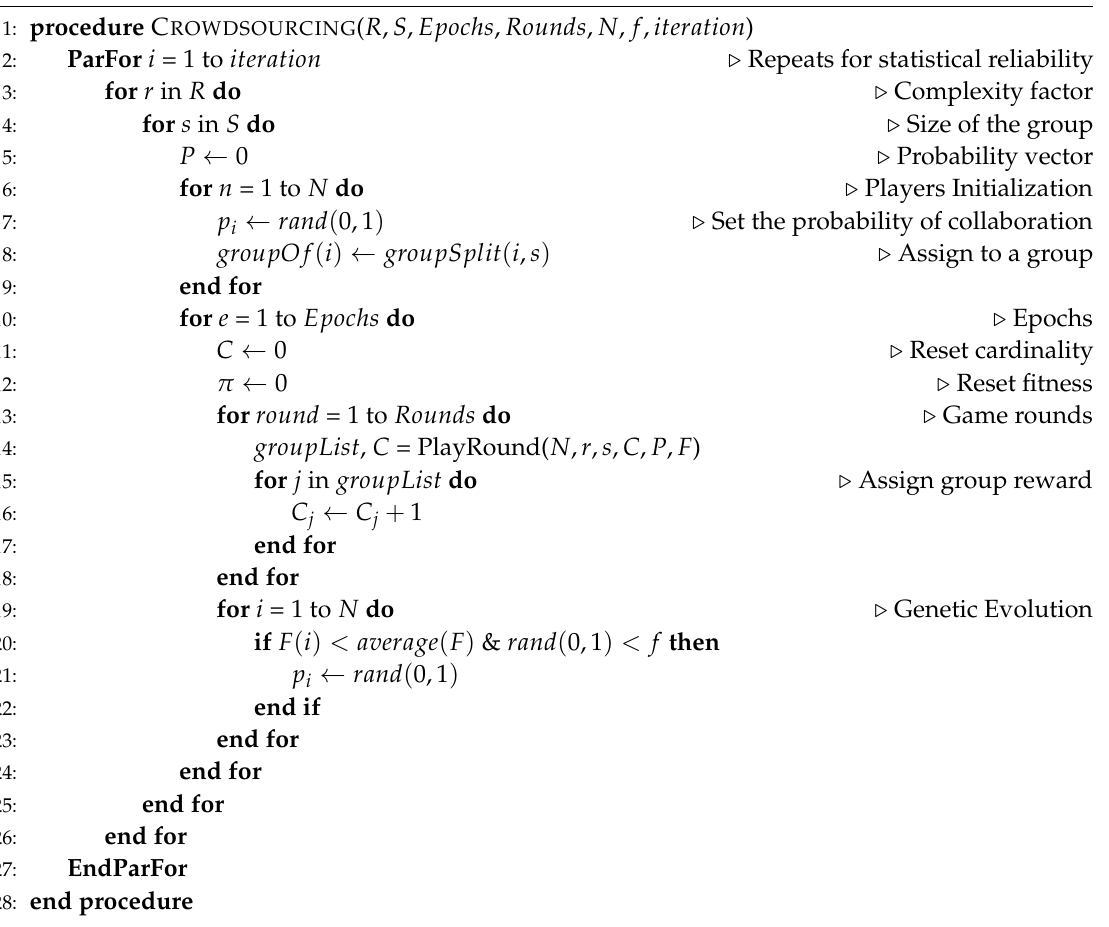
Algorithm A2 Crowdsourcing Simulation